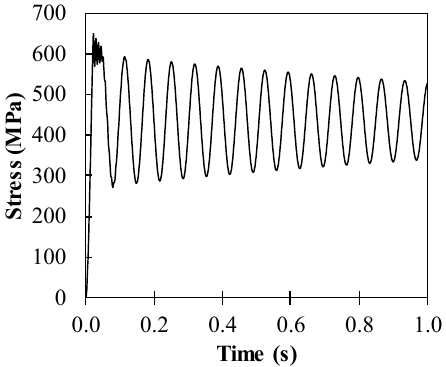
Figure 8. The maximum stress in CFRP with regard to the thicknesses of both steel slab and CFRP pipe.